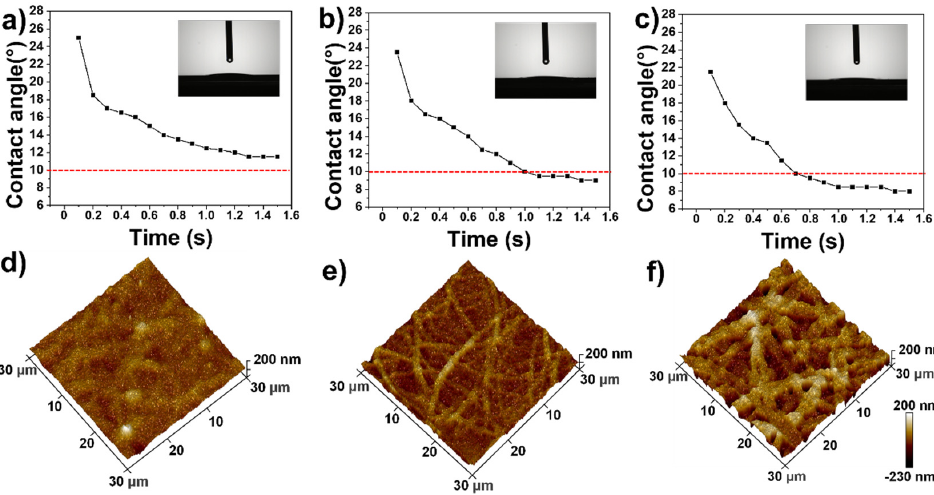
Figure 8. Water contact angles of structural color film with spray passes of ( a ) N = 10, ( b ) N = 20, and ( c ) N = 30 at different times; 3D AFM images of structural color film with spray passes of ( d ) N = 10, ( e ) N = 20, and ( f ) N = 30.